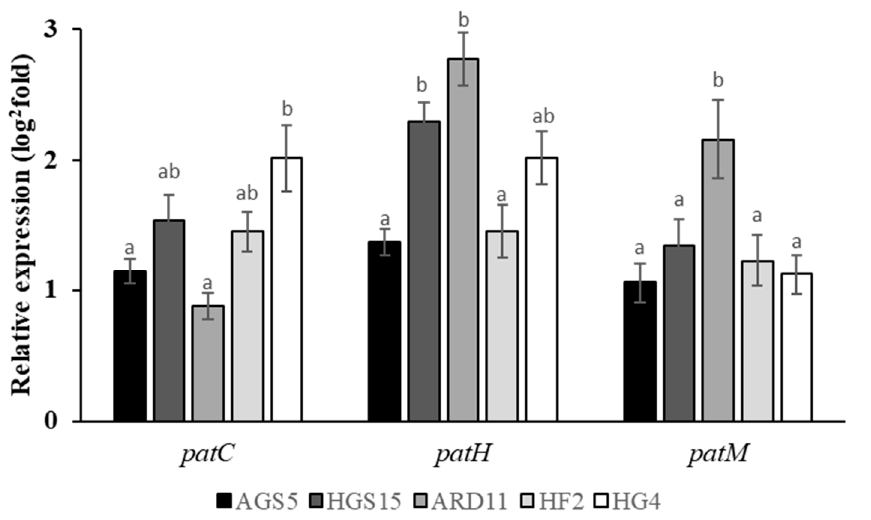
Figure 4. Expression levels of patulin biosynthesis pathway genes ( patC, patH, patM ) in P. expansum isolates, grown on PDA medium. Expression levels were analyzed by qRT-PCR at 48 h and the cDNA samples were standardized using the sensitive isolate as reference and were normalized using the endogenous b-tubulin gene. Different letters on the columns indicate statistically significant differences between the isolates according to Tukey’s test ( p < 0.05). Vertical lines on the columns indicate the standard error of the mean.